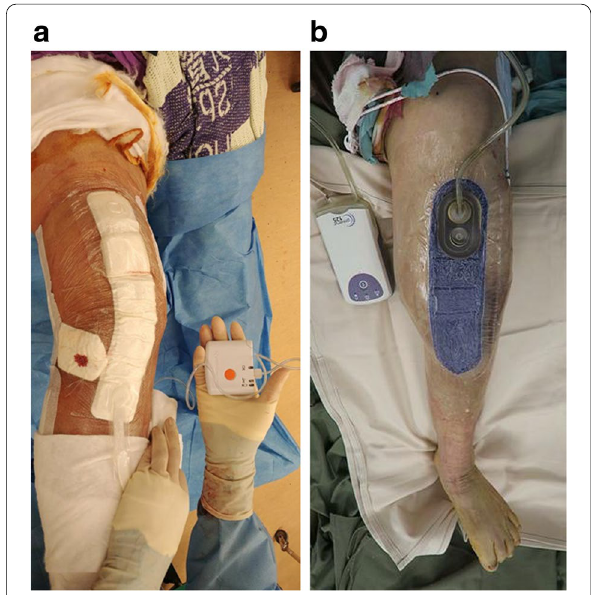
Fig. 1 ciNPWT devices used in revision arthroplasties. a PICO system b Prevena